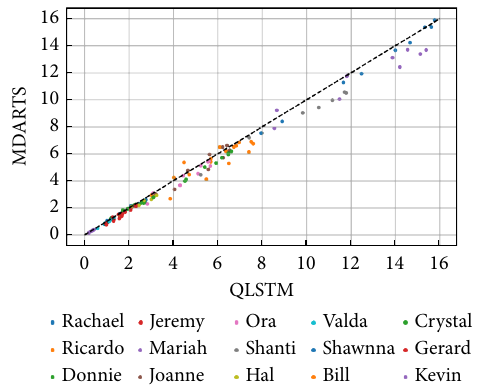
Fig. 7 Pinball loss comparison between MDARTS and QLSTM.